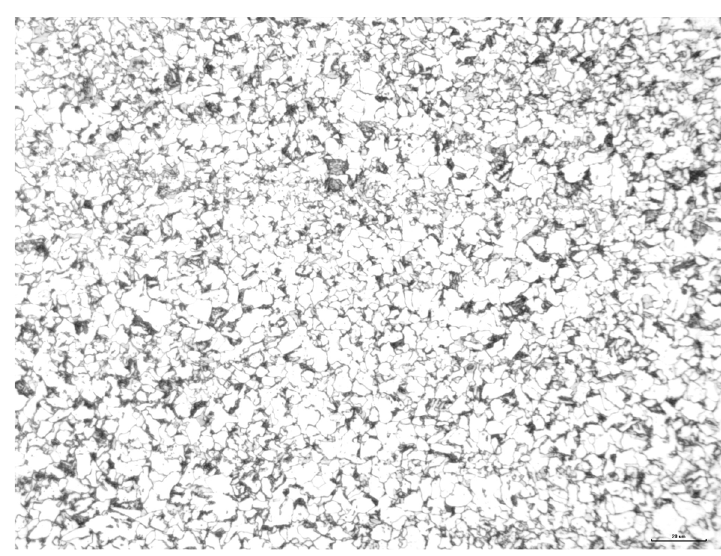
Fig. 7 Microstructure of fine-grained